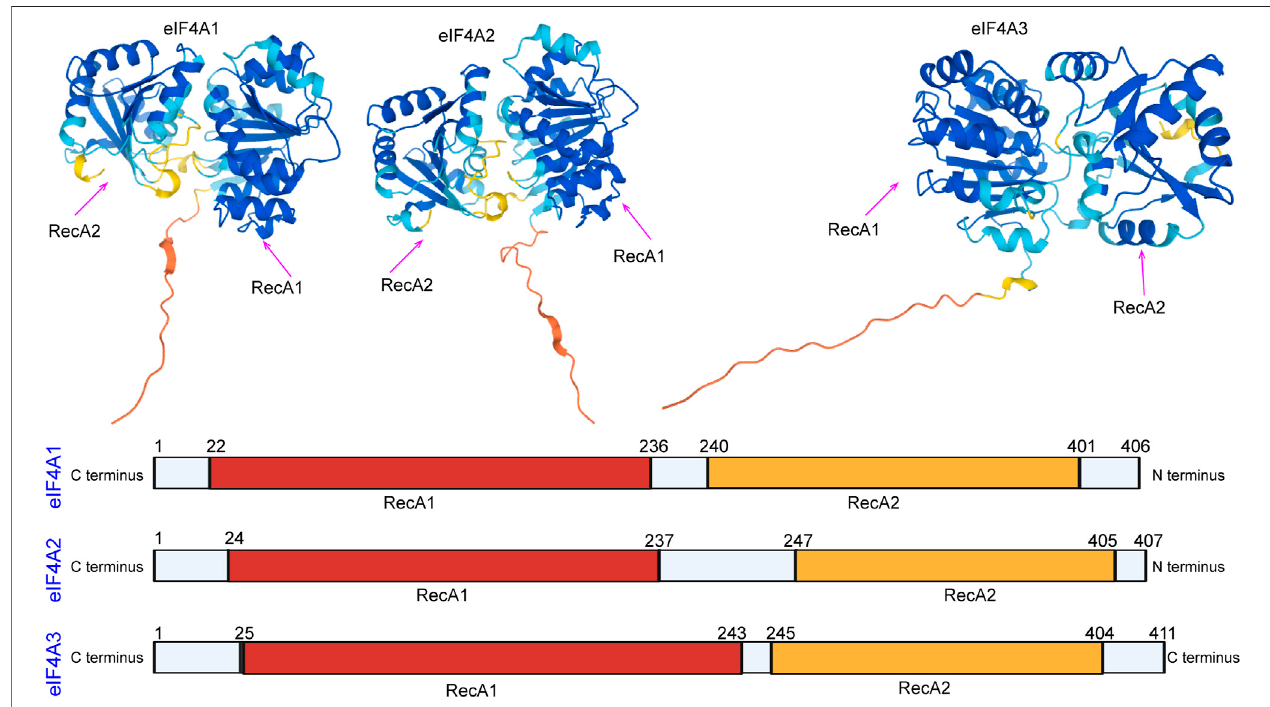
FIGURE1| DomainorganizationofeIF4A1,eIF4A2,andeIF4A3.TheN-terminalRecA-likedomainisdepictedinyellow,andtheC-terminusisdepictedinred.The domain organization of the eIF4A family was downloaded from the alphafold protein structure database (https://alphafold.ebi.ac.uk/).